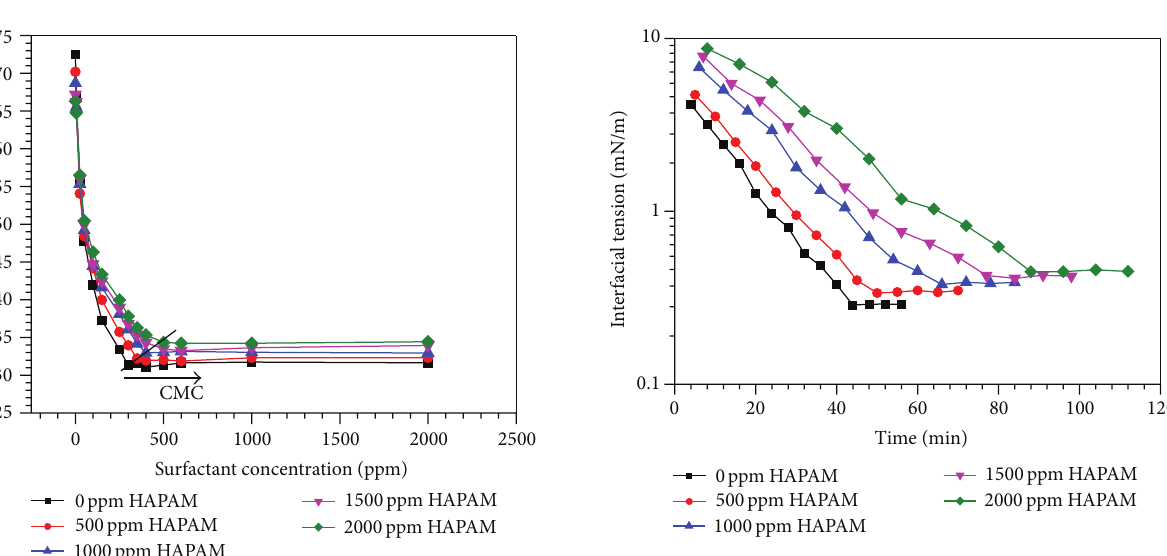
Figure 3: Effect of HAPAM concentrations on surface tensions of BS-12.